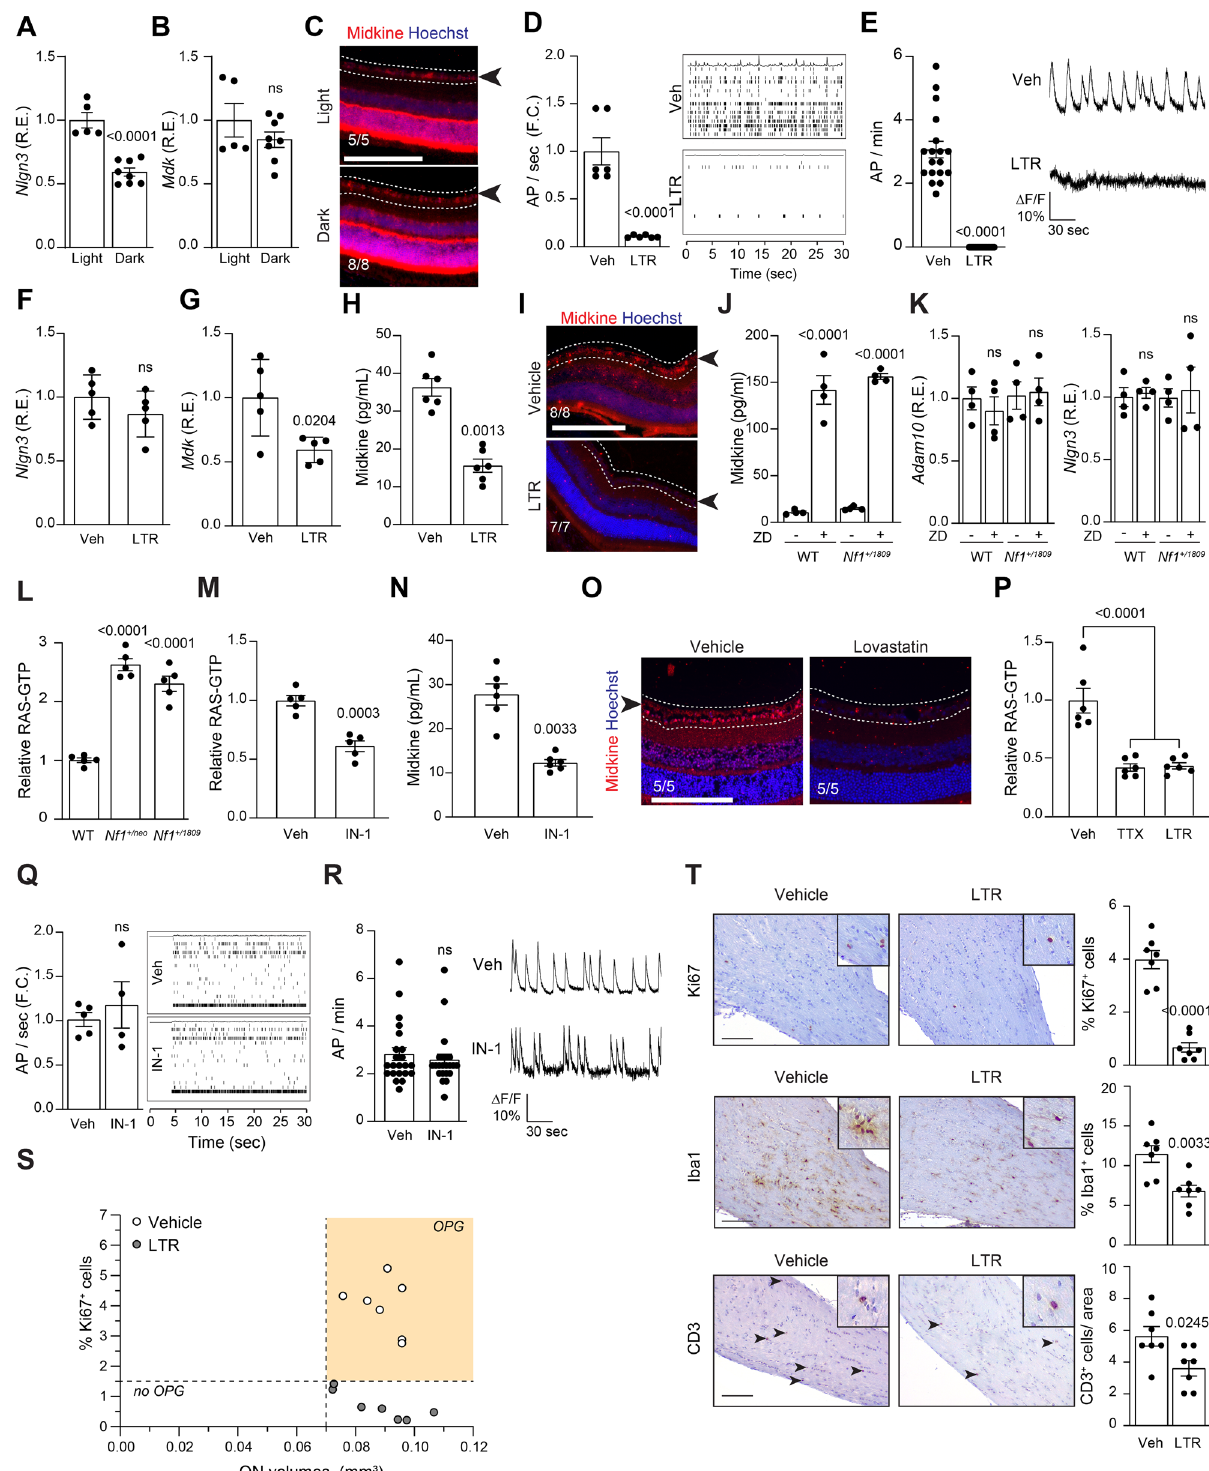
not develop pNFs at 6 months of age (0/52; Fig. 4B). Moreover, Nf1 f/1809 ; Hoxb7-Cre mice exhibited neither enlarged DRGs (Fig. 4C) nor histological features of pNFs (Fig. 4D, E), and their DRGs contained fewer total cells, as well as fewer SOX10 + Schwann cell precursors, the cell of origin for these pNF tumors (Fig. 4F, G), demonstrating that mice harboring the Nf1 R1809C mutation fail to develop